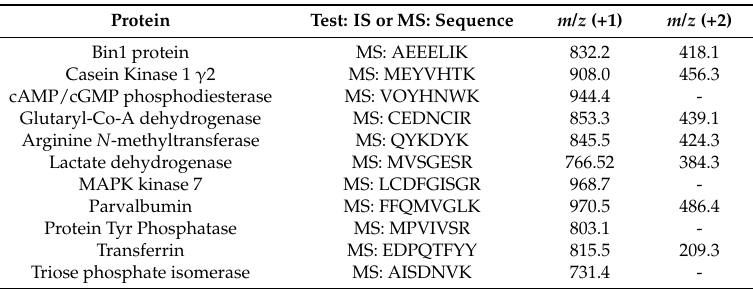
Table 1. List of fragment ions monitored for protein identification. Protein Test: IS or MS: